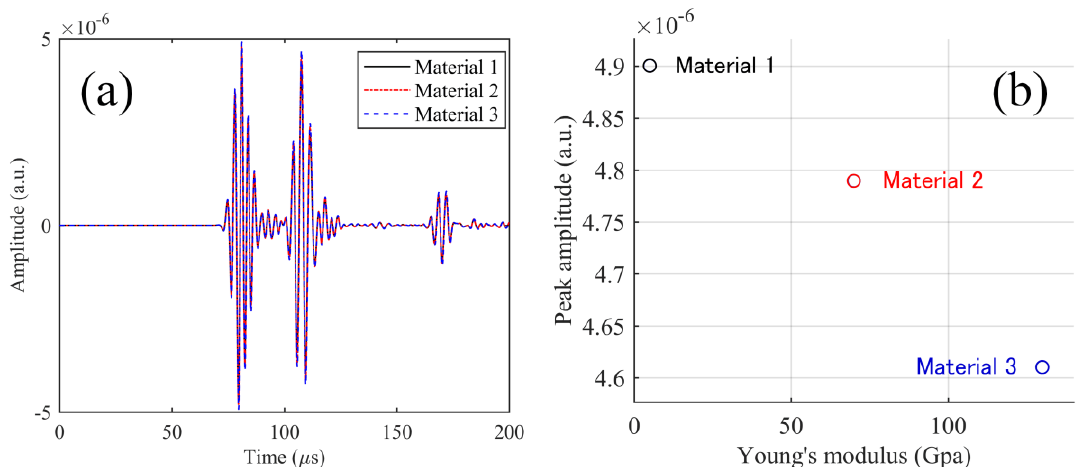
Figure 10. ( a ) Calculation results of the received waves in PSFBG, corresponding to the three kinds of adhesive materials listed in Table 1; and ( b ) peak amplitudes obtained from the simulation results plotted against Young’s modulus values of the adhesive materials. Table 1. Material properties used for the adhesive model.